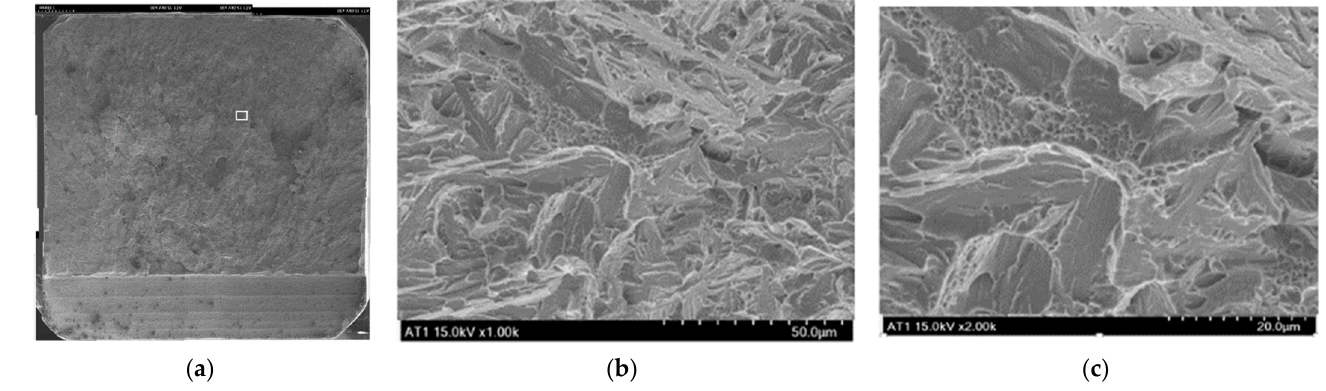
Figure 18. Charpy impact fractured surface of AT specimen. ( a ) indicates that shear lip is small (30×), ( b ) 1000×, and ( c ) 2000× is enlarged SEM of the area indicated by the rectangle near the center of Figure 18a.